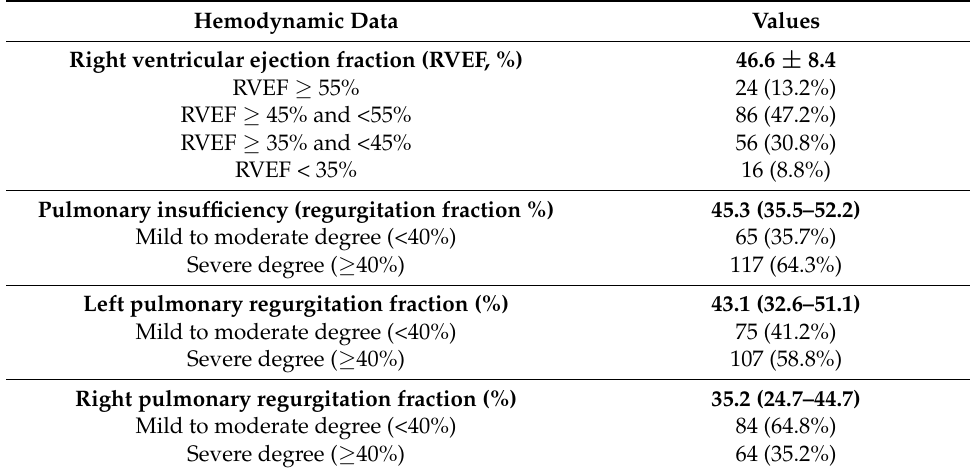
Table 2. Hemodynamic data.